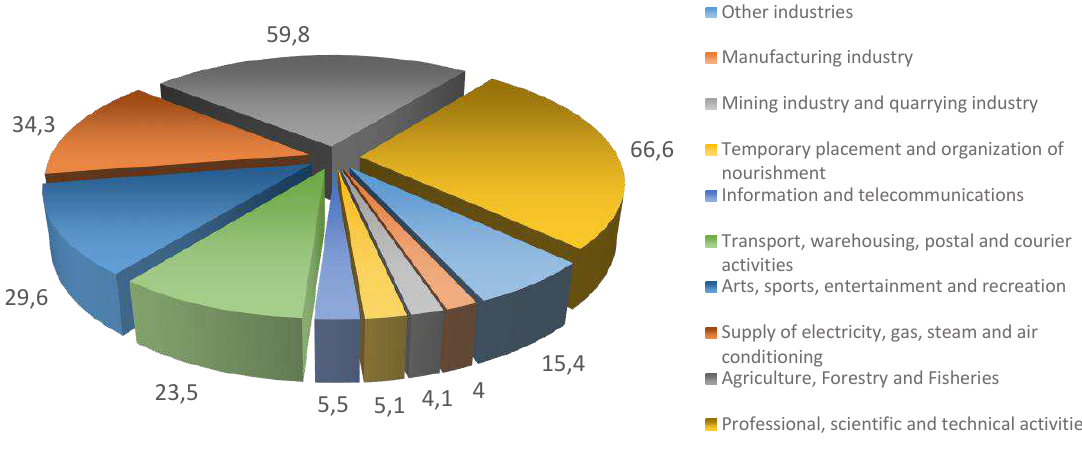
Source: Ministry of Economic Development and Trade of Ukraine (2018)